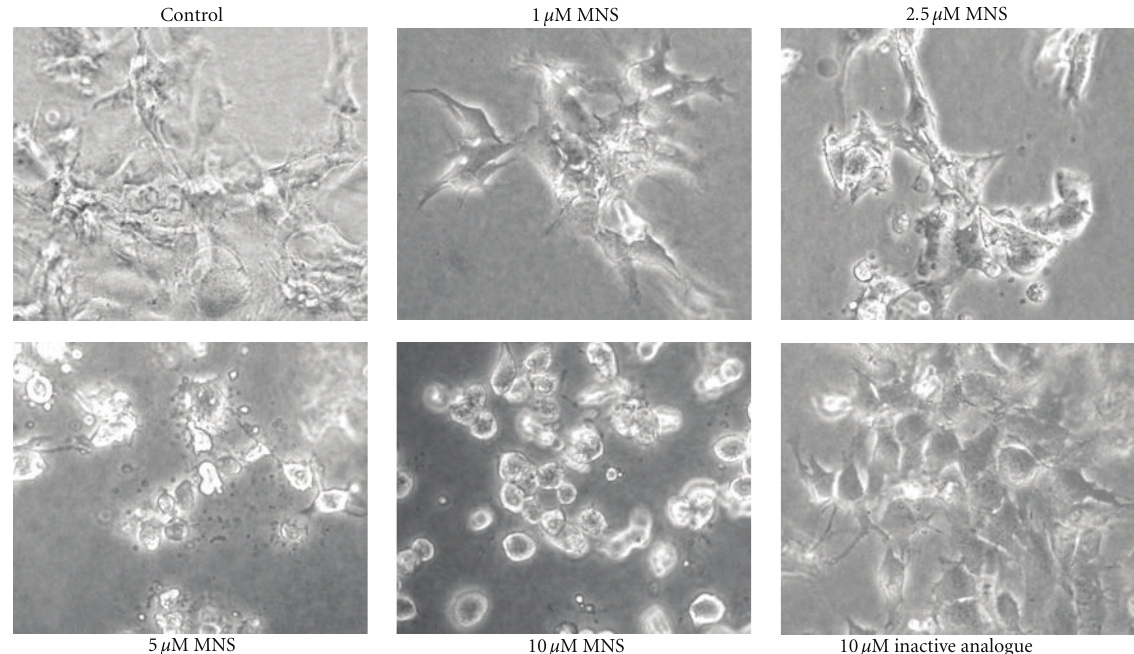
Figure 3: MNS disrupts preformed metastatic 143B cell colonies in a dose-dependent manner. 143B cell colonies 4 hours after incubation in the presence of increasing concentrations of MNS (1, 2.5, 5, and 10 μ M), 10 μ M of the inactive analogue, or 1% DMSO as a vehicle control. This figure shows representative images from three independent experiments, each with three wells per group.